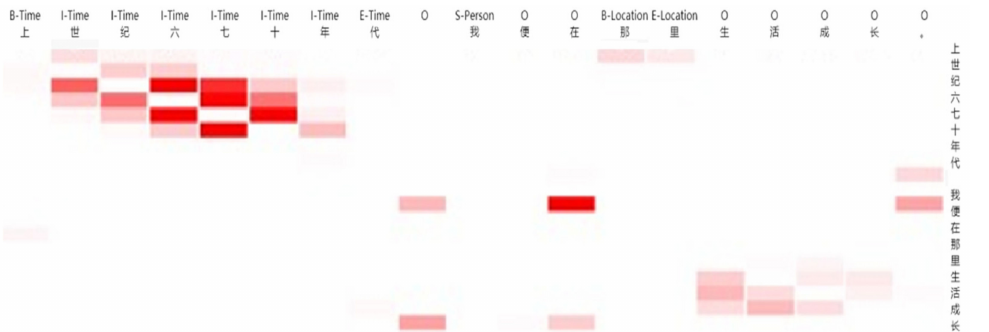
Figure 8. Instance of self-attention visualization 3.